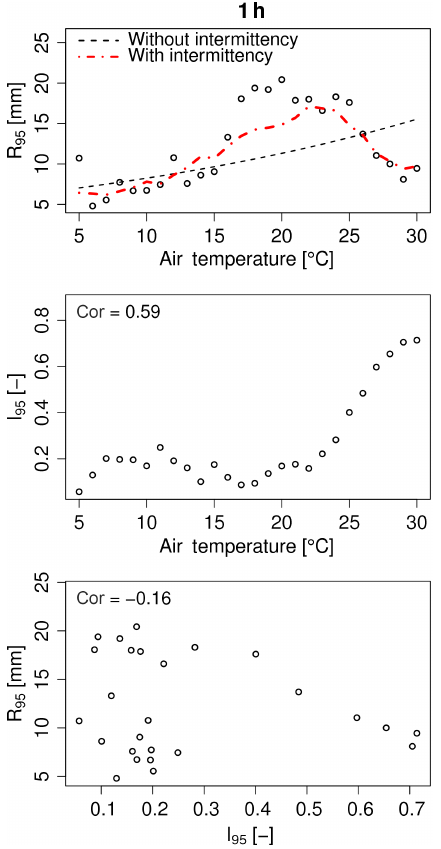
Figure 4. 95th quantile of rainfall amounts at the hourly timescale as a function of temperature and intermittency at AL-Fairhope-3- NE. Black dots denote sample estimates. The black and red lines represent the fitted scaling models given in Eqs. (9) and